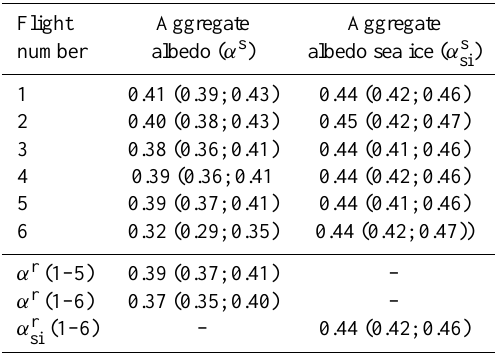
Table 2. Summary statistics on the aggregate surface albedo α s and sea-ice albedo α s along the six processed helicopter flight tracks si from the ICE12 cruise and the respective regional estimates α r and α r . The total regional albedo is calculated with and without flight 6 si data taken into account. The numbers in parentheses in the albedo column denote the respective block bootstrap 95% confidence in- terval on the